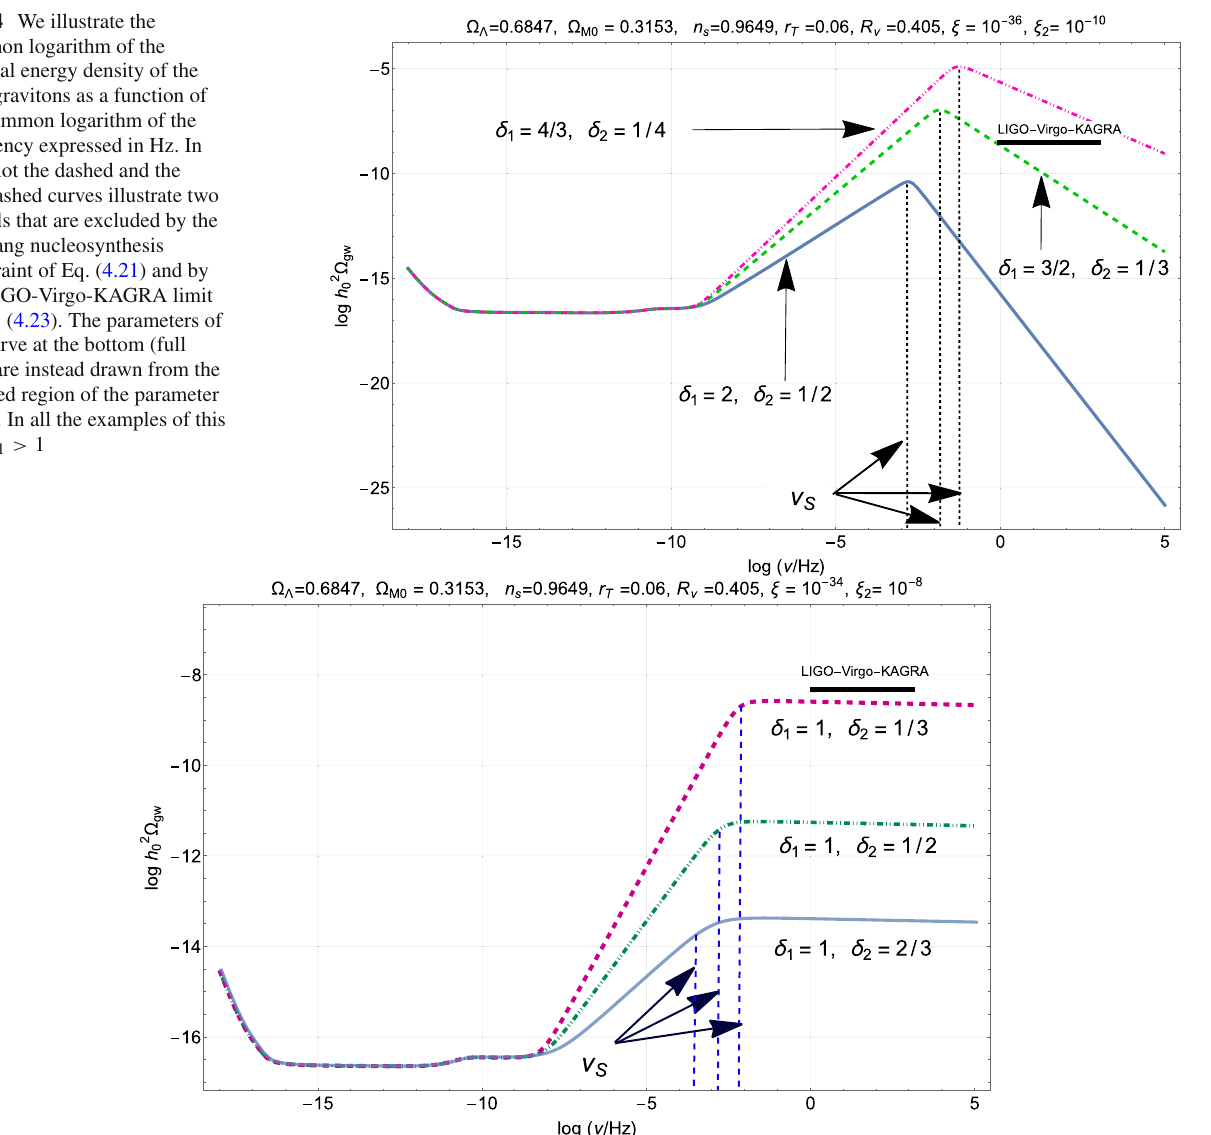
Fig. 5 TheconventionsareexactlythesamealreadyexplainedinFig.4 but the spectral energy is illustrated for a different choice of the parame- ters. The dashed curves at the top of the figure is barely compatible with the limits set by Eq. (4.23). If δ 1 > 1 (see e.g. Fig. 4) the spectral energy